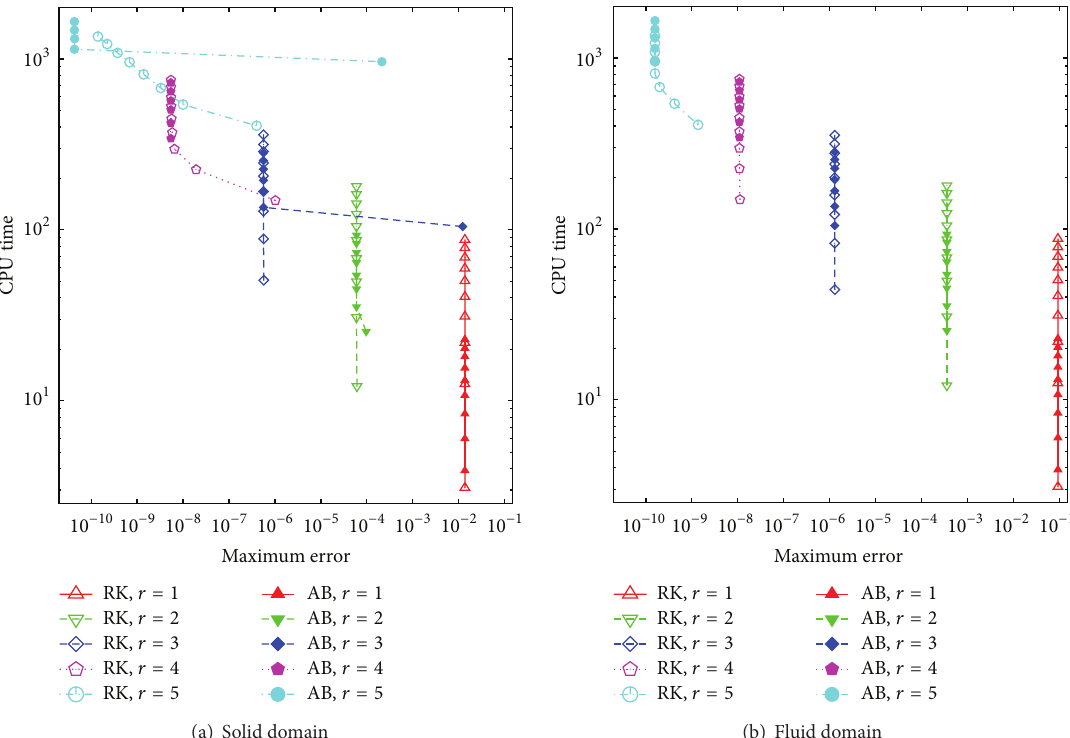
Figure 6: Accuracy with respect to CPU time consumptions (in seconds) with the RK and the AB time discretizations. The mesh step size is fixed to be ℎ = 1/20 , and the time step refinement gives a series of numerical results with various lengths of the time step for each element order.